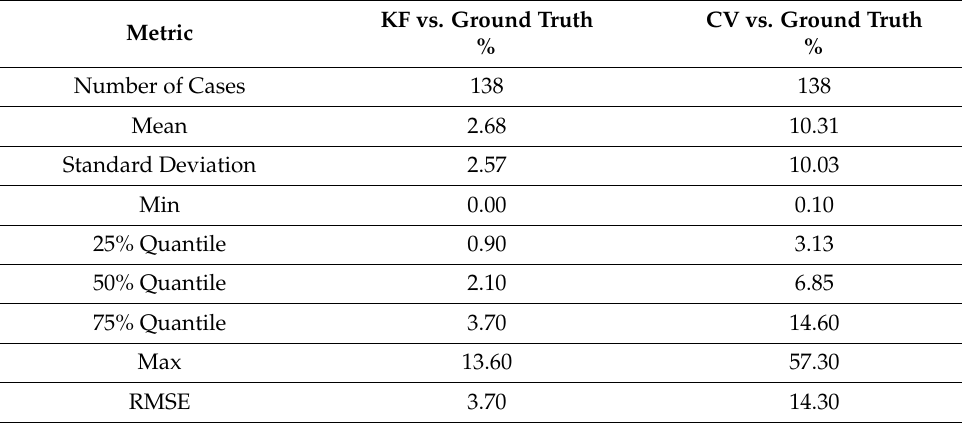
Table 5. Residuals of CV and KF Predictions vs. Ground Truth (Hourly Case). KF vs. Ground Truth CV vs. Ground Metric